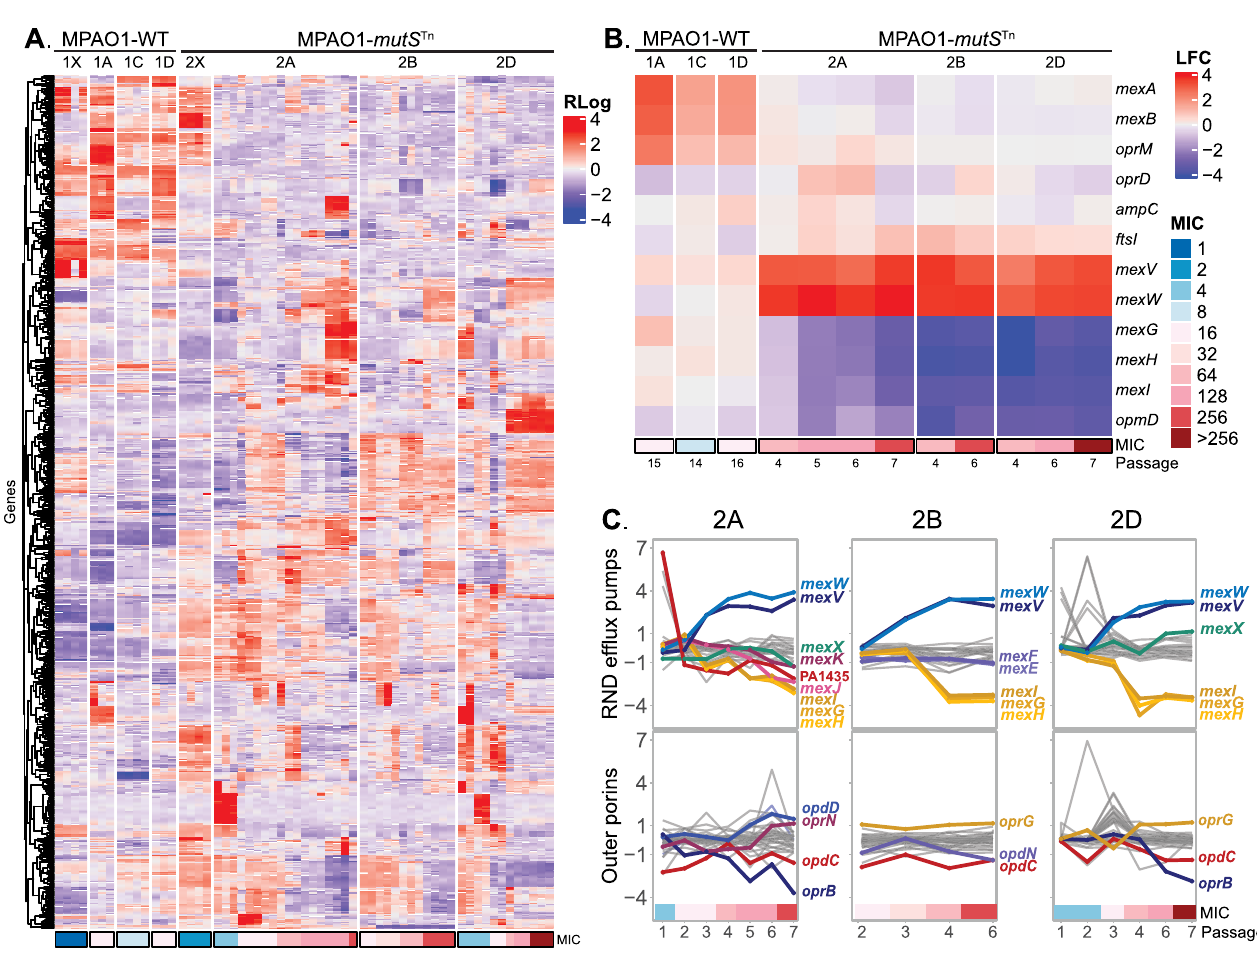
Fig 3. Dissimilar transcriptome profiles highlight lack of involvement of major cephalosporin resistance genes in CZA resistance in MMR-deficient lineages and demonstrate MexVW overexpression. Three lineages of MPAO1-WT and MPAO1- mutS Tn were selected for transcriptomic analysis and 3 biological replicates from 1 isolate per passage underwent RNA sequencing. (A) A clustered heatmap of the top 750 most variable genes across CZA-resistant isolates is shown. Rlog normalized levels of expression of each gene (rows) were scaled within each row. Isolates (columns) are grouped by lineage and arranged by genotype with WT on the left and hypermutators on the right. Within each lineage, isolates are arranged from left to right in order of increasing number of passages under CZA selection, with the corresponding MIC indicated at the bottom. 1X and 2X represent the MPAO1-WT and MPAO1- mutS Tn parental strains of the respective lineages. (B) LFC with respect to their corresponding ancestor of the terminal MPAO1-WT isolates (first 3 columns) and CZA-adapted MPAO1- mutS Tn isolates (last 9 columns). The rows represent 6 major beta-lactam resistance genes in P . aeruginosa from 4 major resistance pathways (encoding the MexAB-OprM efflux pump, OprD outer membrane porin, PDC beta-lactamase, and penicillin-binding-protein 3 FtsI). Data for 2 differentially expressed RND efflux pumps in the MPAO1- mutS Tn lineages (MexVW and MexGHI-OpmD) are additionally shown. (C) Expression levels of RND efflux pumps and outer membrane porins in MPAO1- mutS Tn lineages during the course of the CZA adaptation experiment. The vertical axis represents the LFC of expression levels compared to the early isolates, and the horizontal axis shows the passage number. CZA MIC is indicated with color tiles under the axis. Lines are colored and labeled if the respective gene reached a LFC > 1.0 in the terminal isolates of the lineage. The underlying data to generate this figure can be found in S2 Data. CZA, ceftazidime/avibactam; MMR, mismatch repair; WT, wild type.